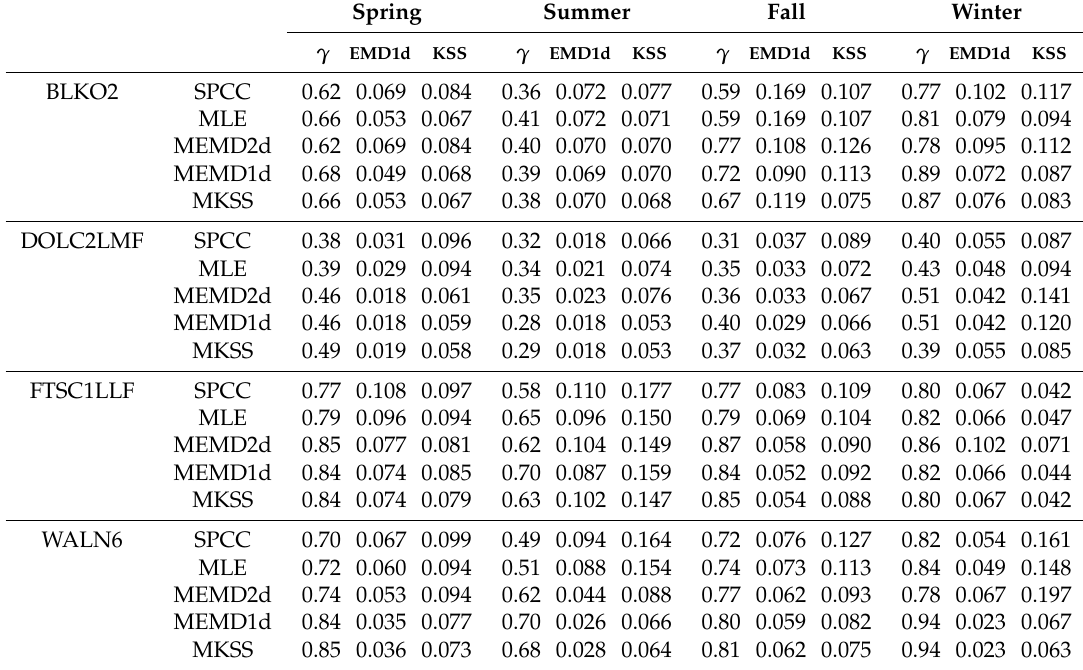
Table 3. Results for conditional